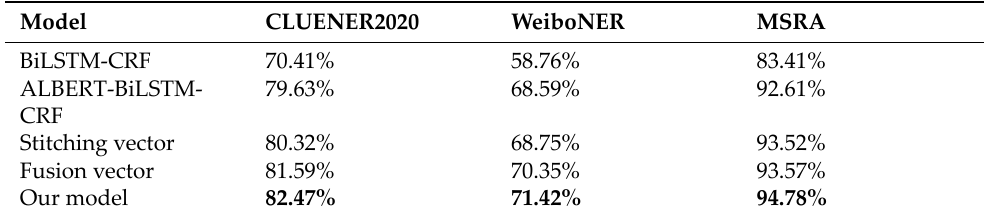
Table 3. Ablation results.